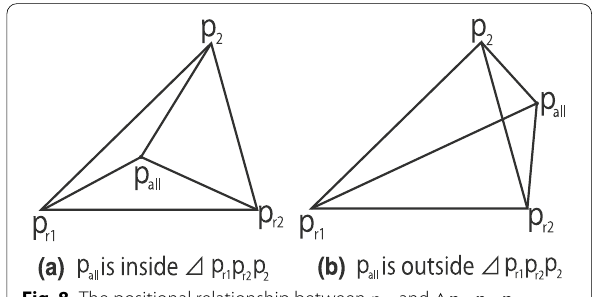
Fig. 8 The positional relationship between p all and △ p r 1 p r 2 p 2